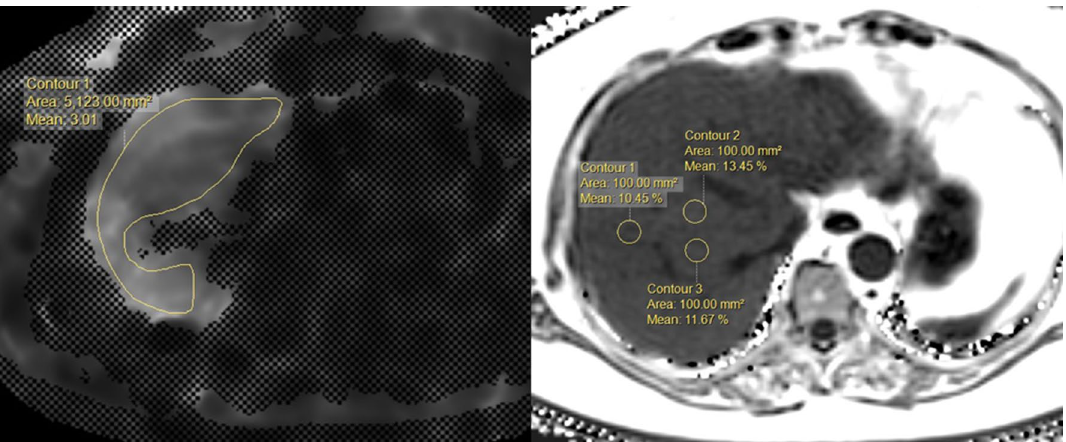
Figure 2. The placement of the ROI for MR stiffness and fat measurement at the workstation. In the MR stiffness map (right), the largest ROI was placed within the contour of the liver and the result are expressed as the mean stiffness (kPa). For the fat quantification (left), three circular ROIs were placed within each Couinaud